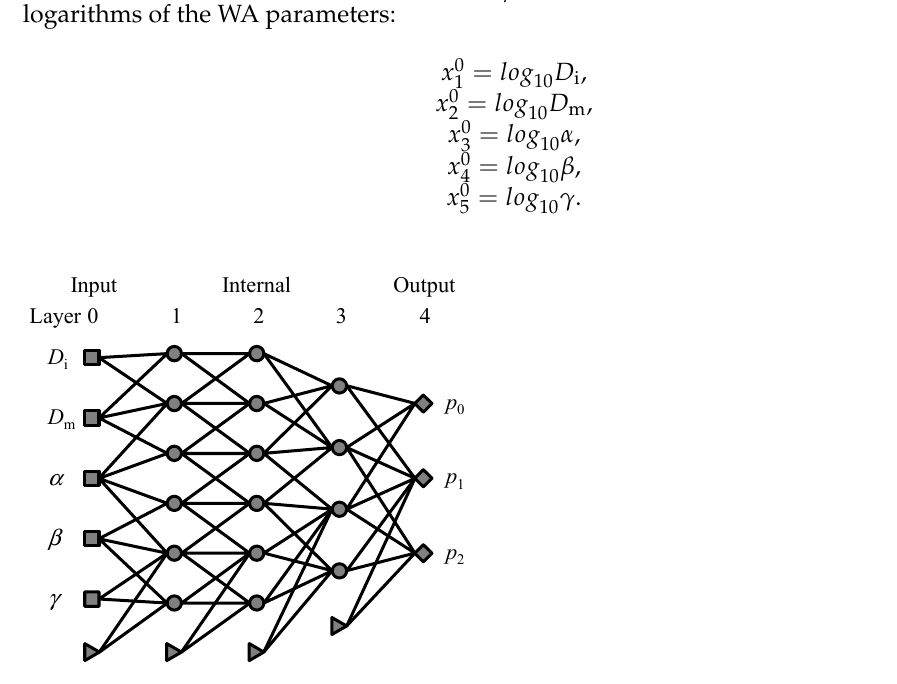
Figure 2. Schematic of ANN architecture. Nodes in each layer are indicated as square, circle, diamond, and triangle for the input layer, internal layers, output layer, and bias, respectively. Not all connections between adjacent layers are drawn.